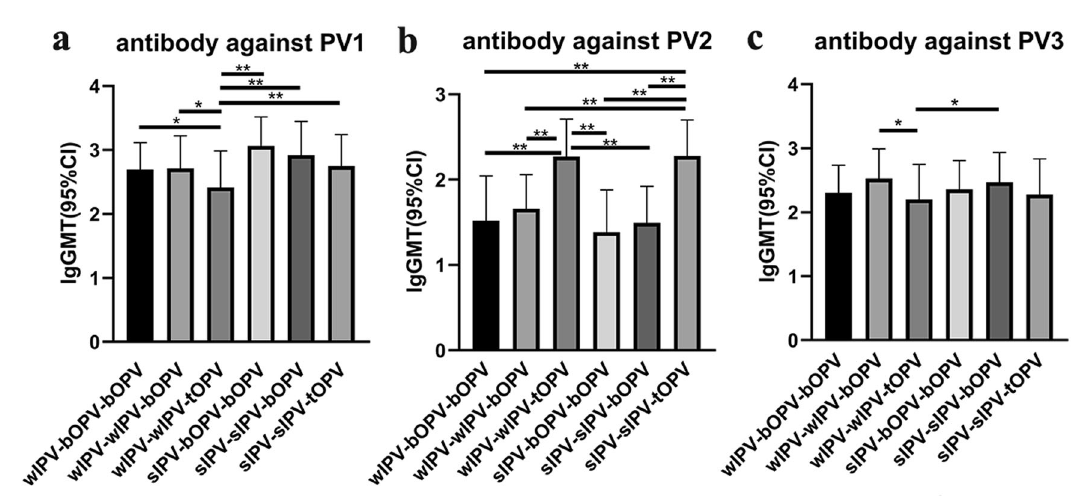
Fig. 3 GMT for neutralizing antibody against PV1, PV2, and PV3 before booster immunization at 48 months of age. Differences in antibody levels between groups were compared after log-transformation of the GMT (95%CI). Statistical test: Kruskal – Wallis test; * p < 0.05; ** p < 0.001. error bars: Standard Deviation (s.d.). a GMT for neutralizing antibody against PV1. b GMT for neutralizing antibody against PV2. c GMT for neutralizing antibody against PV3. wIPV-bOPV-bOPV: n = 58; wIPV-wIPV-bOPV: n = 73; wIPV-wIPV-tOPV: n = 109; sIPV-bOPV-bOPV: n = 20; sIPV-sIPV-bOPV: n = 71; sIPV-sIPV-tOPV: n =